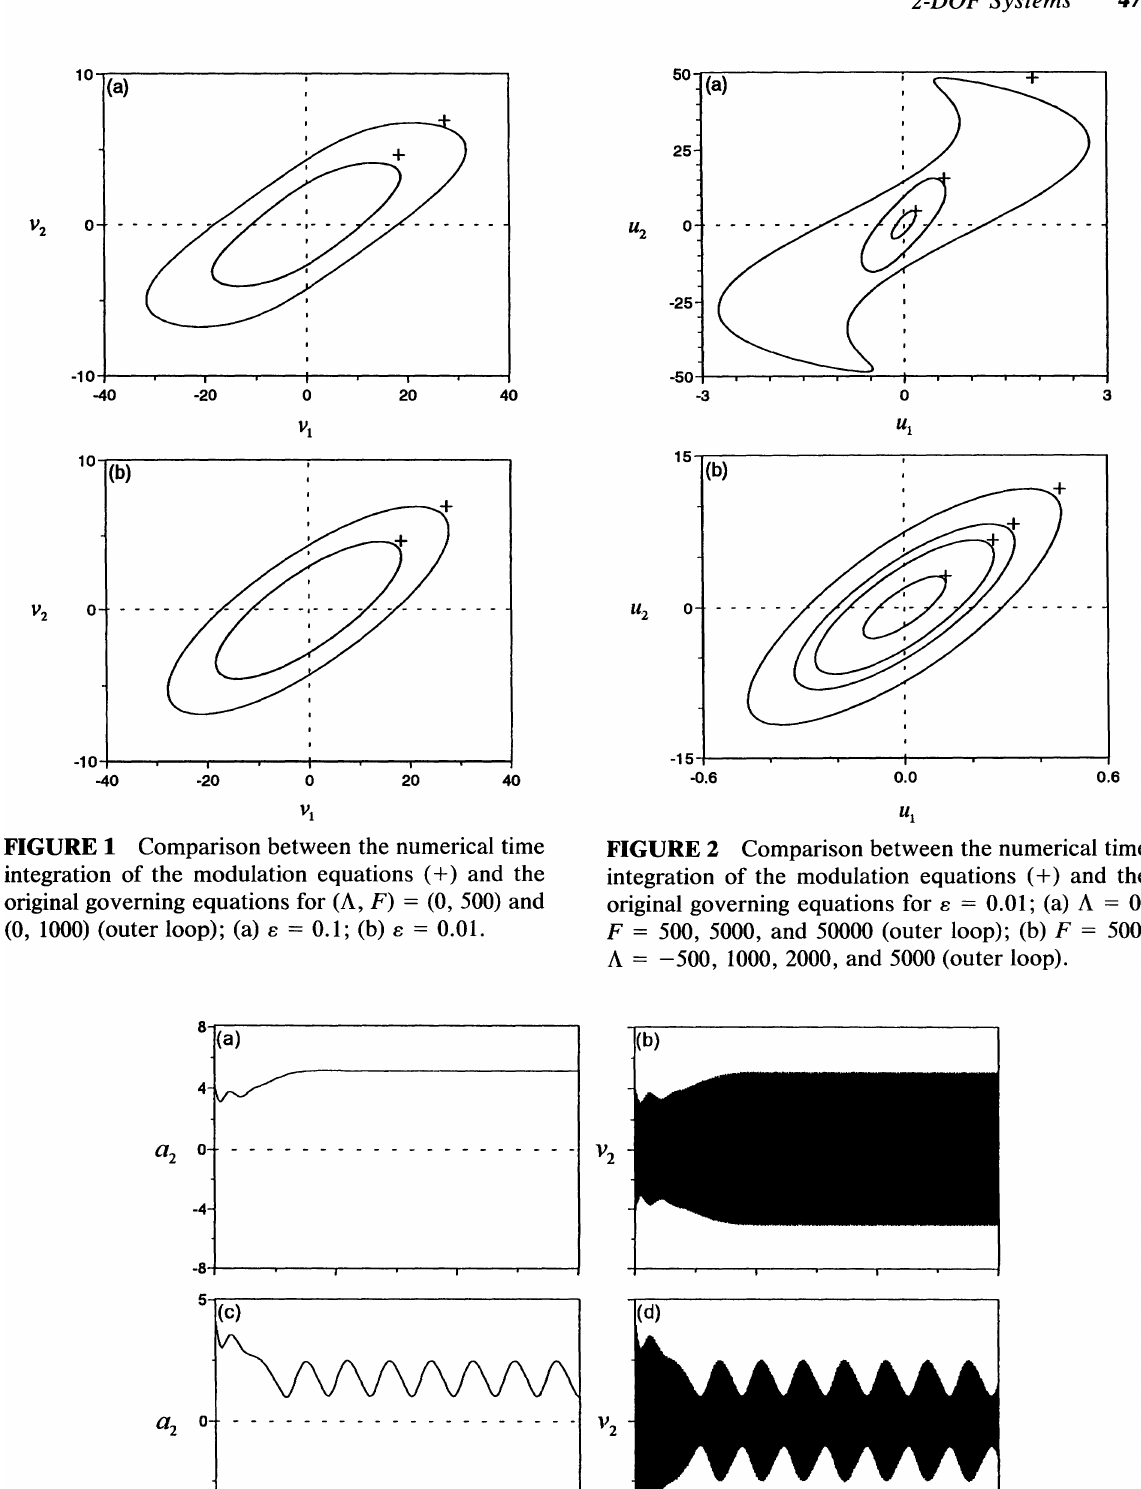
FIGURE 3 Comparison between the numerical time integration of the modulation equa tions (left) and the original governing equations (right). (A, F) = (600, 379) for (a) and (b); (A, F) = (600, 329) for (c) and